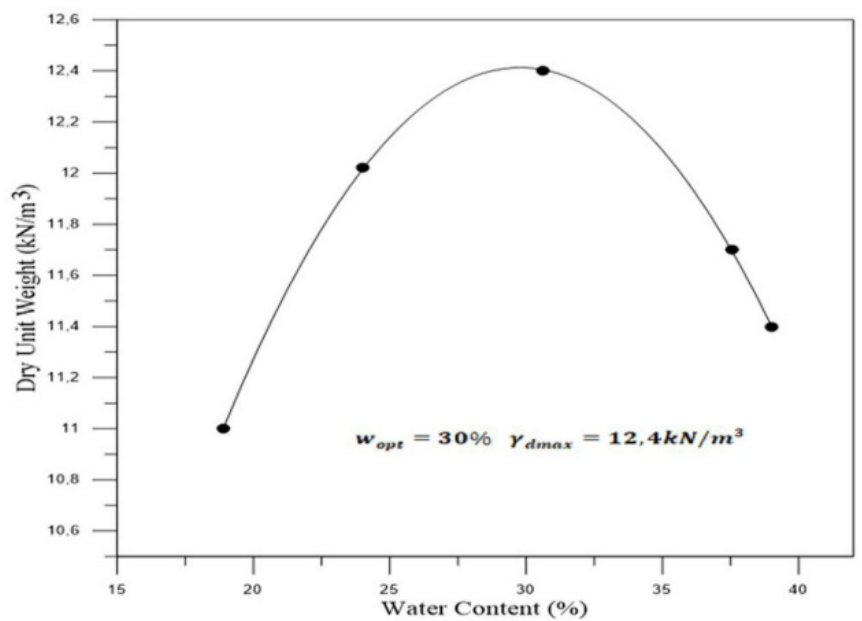
Figure 3. Water content and dry unit weight relation [40].